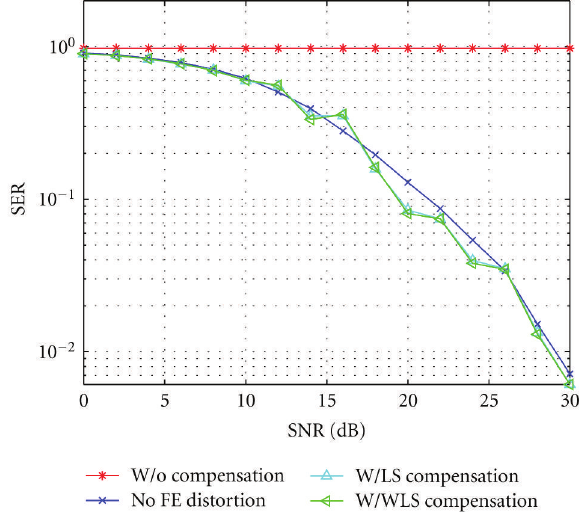
Figure 18: Measured SER versus SNR performance curves for 64- QAM OFDM system with sparse pilot; CFO = 45KHz; veh. A channel model with 39 taps; ensemble average over 10 realizations with a fixed